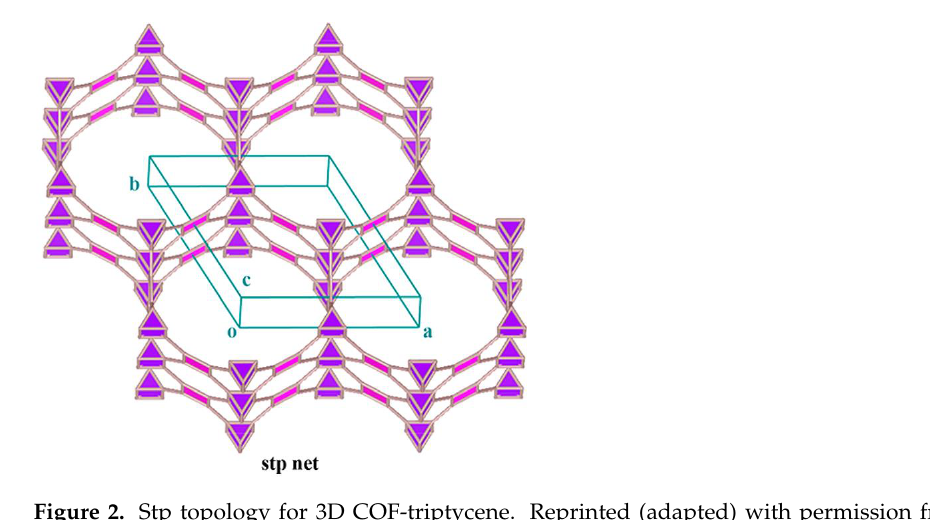
Figure 2. Stp topology for 3D COF-triptycene. Reprinted (adapted) with permission from [19].